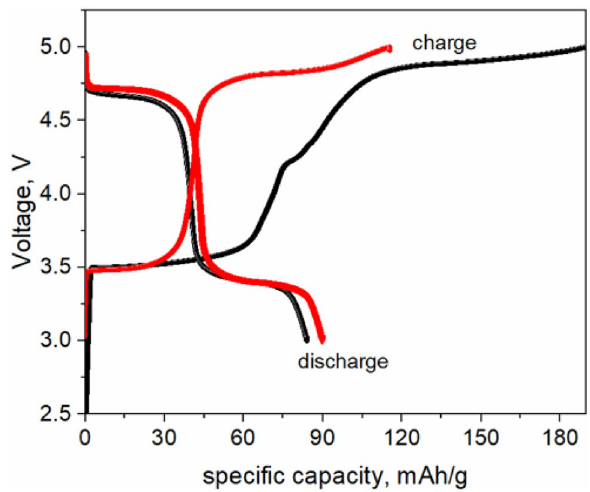
Figure 2. First two charge/discharge profiles of LiCo 0.5 Fe 0.5 PO 4 .